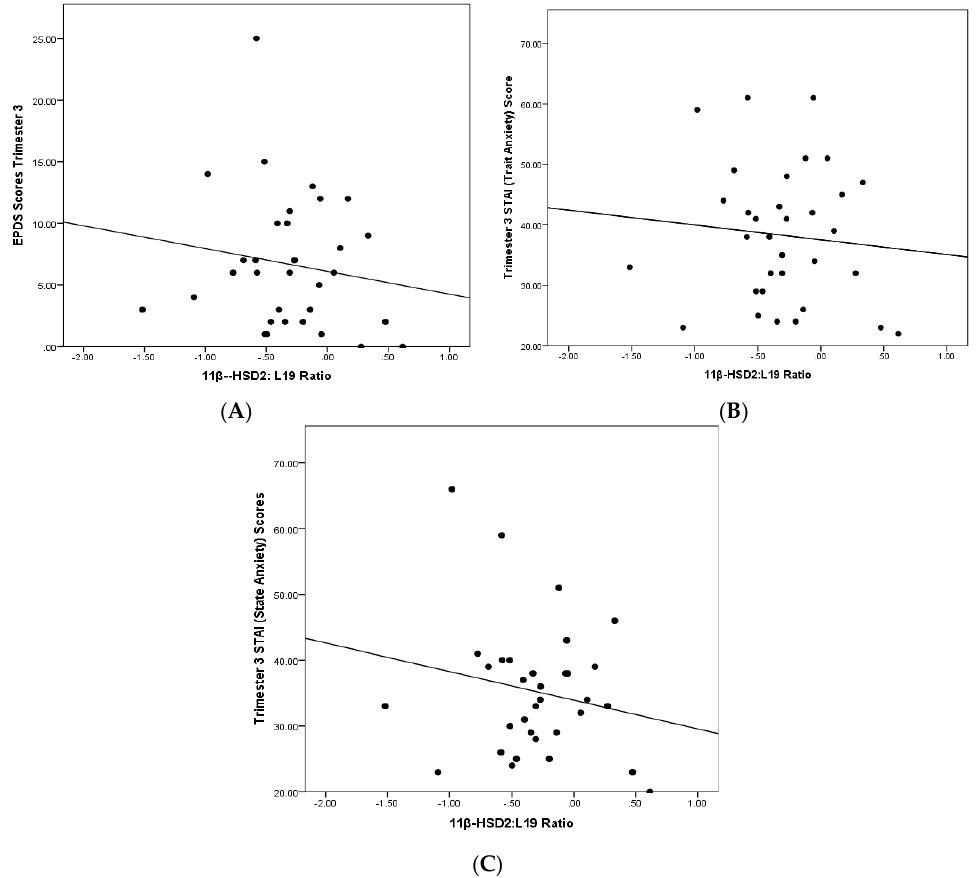
Figure 1. Placental HSD11B2 expression and Trimester 3 ( A ) EPDS scores ( M = 6.22, SD = 4.50); ( B ) STAI-T scores ( M = 36.48, SD = 10.38); and ( C ) STAI-S scores ( M = 34.35, SD = 10.30).